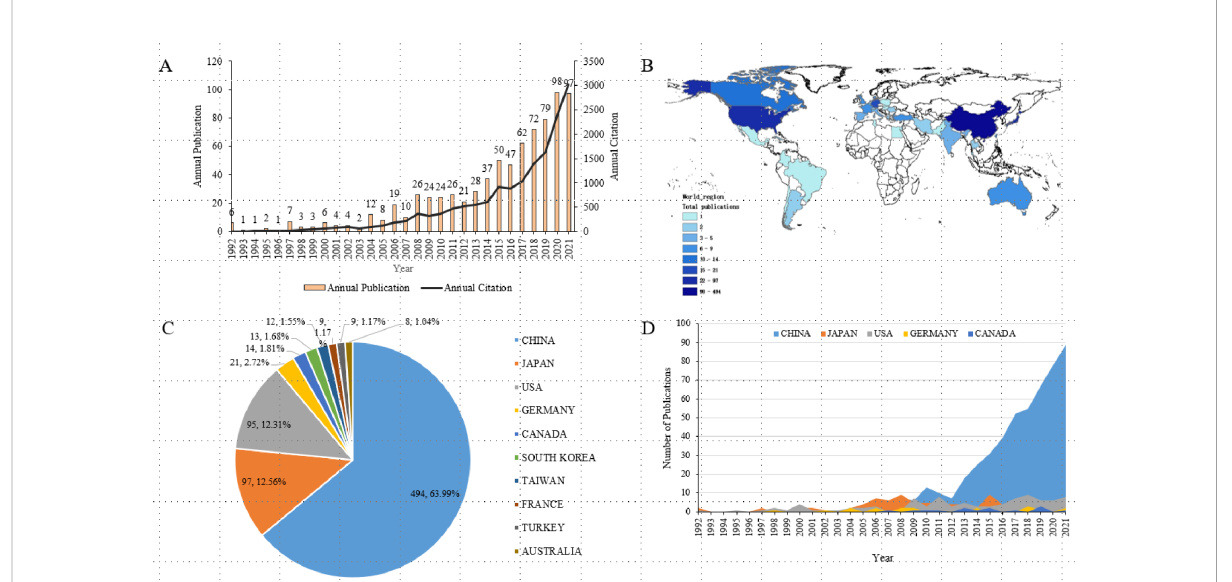
FIGURE 2 Global trends of publications on SONFH in the last 30 years. (A) Annual publications and annual citations on SONFH from 1992 to 2021. (B) Geographical distribution of publications on SONFH from 1992 to 2021. (C) The total number and percentage of publications from the top 10 countries/regions. (D) The annual publications in the top 5 proli fi c countries/regions from 1992 to